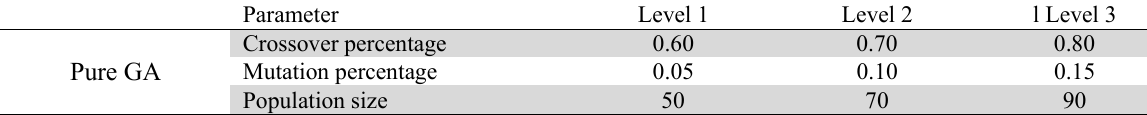
Considered Levels of parameters of genetic